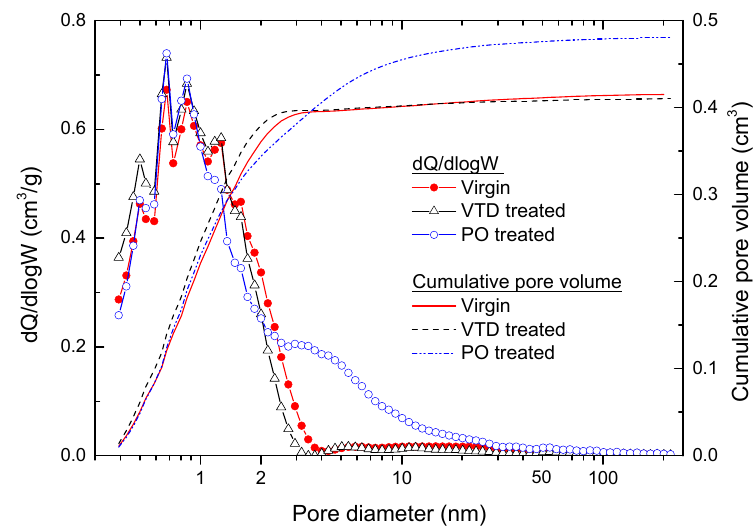
Figure 3. Pore volume distribution of virgin, VTD (vacuum thermal desorption) treated and PO (partial oxidation) treated spent GAC samples as a function of the pore diameter estimated by the nonlocal density functional theory (NLDFT) method.